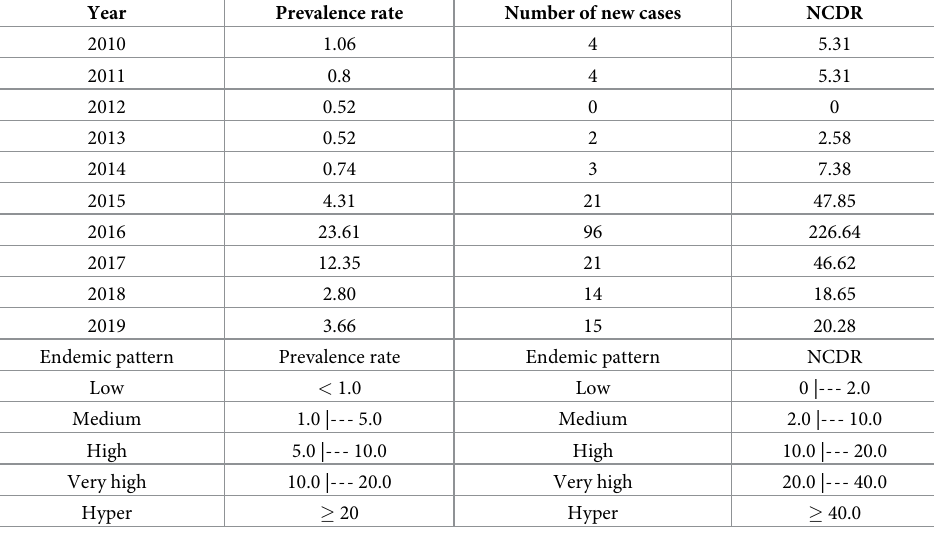
NCDR: new case detection